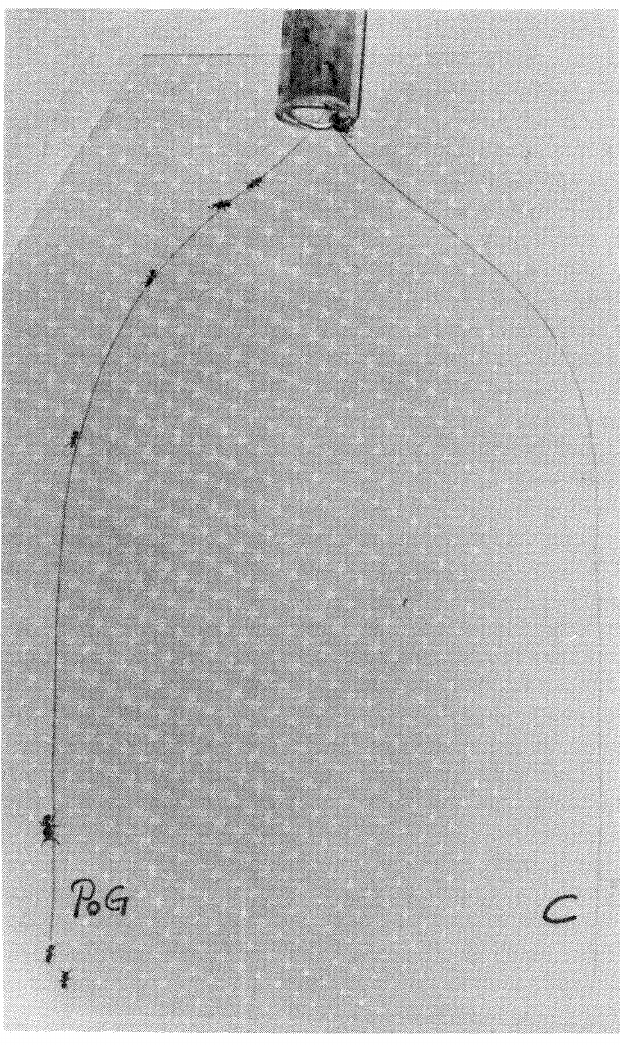
Fig. 6. Trail test with Orectognathus versicolor. Artificial trails drawn with secretions from the poison gland (PoG) and Dufour’s gland (C), both originating at the opening of the nest tube, are offered simultaneously. All workers follow the poison gland